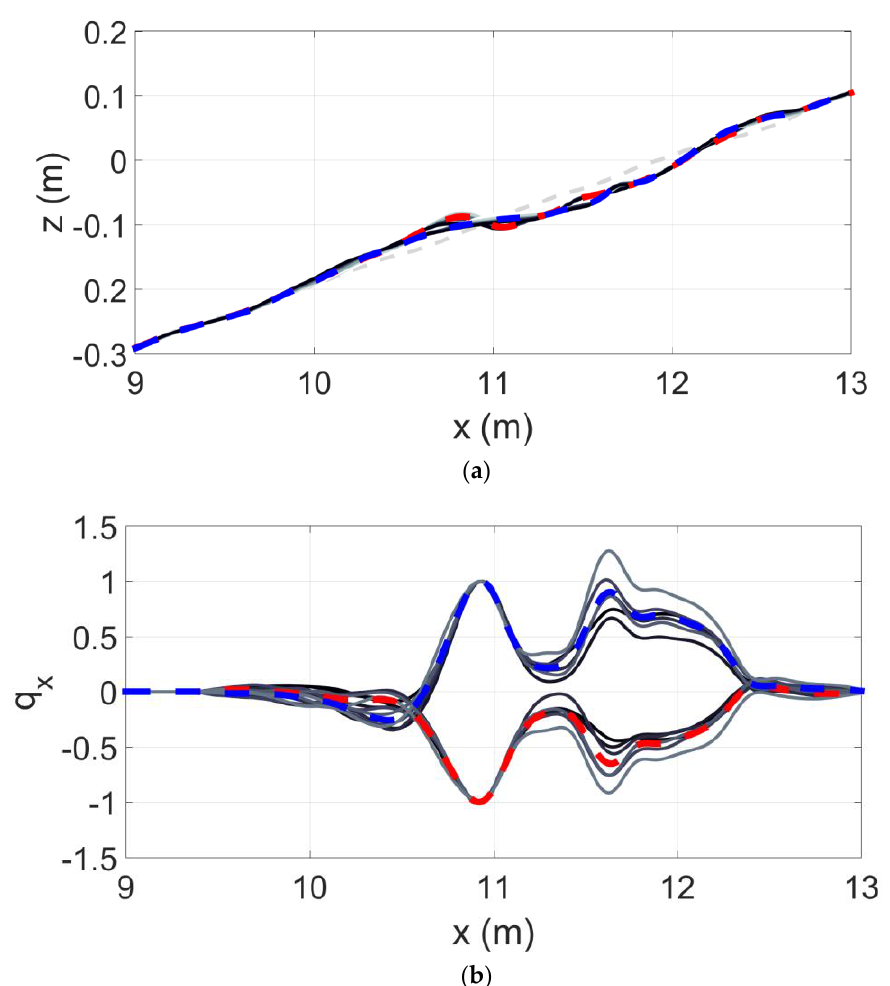
Figure 15. ( a ) Profile evolution (sequential beach profiles) for a cyclic wave climate, Case C, with initial (dashed blue), intermediate (thin grey) and final (thick black) profiles. The bar moves on and offshore as a result of wave height changes in a repeated cycle. ( b ) Local sediment transport centered and normalized according to the peak in transport at the active breaker bar, together with the mean transport patterns (dashed red and blue lines).